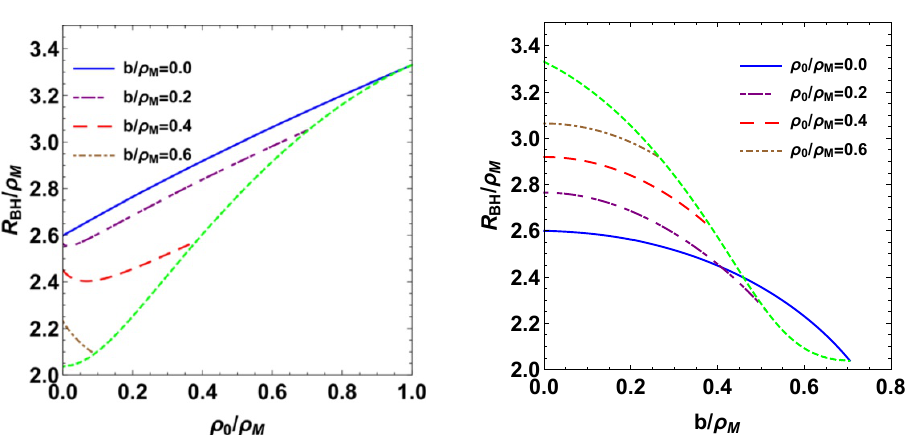
Figure 5 . Dependence of the radius of the shadow on the rotation parameter b and the scale of transition (cid:26) 0 for a rotating squashed KK black hole. The green dashed line denote the boundary between existence and nonexistence of black hole